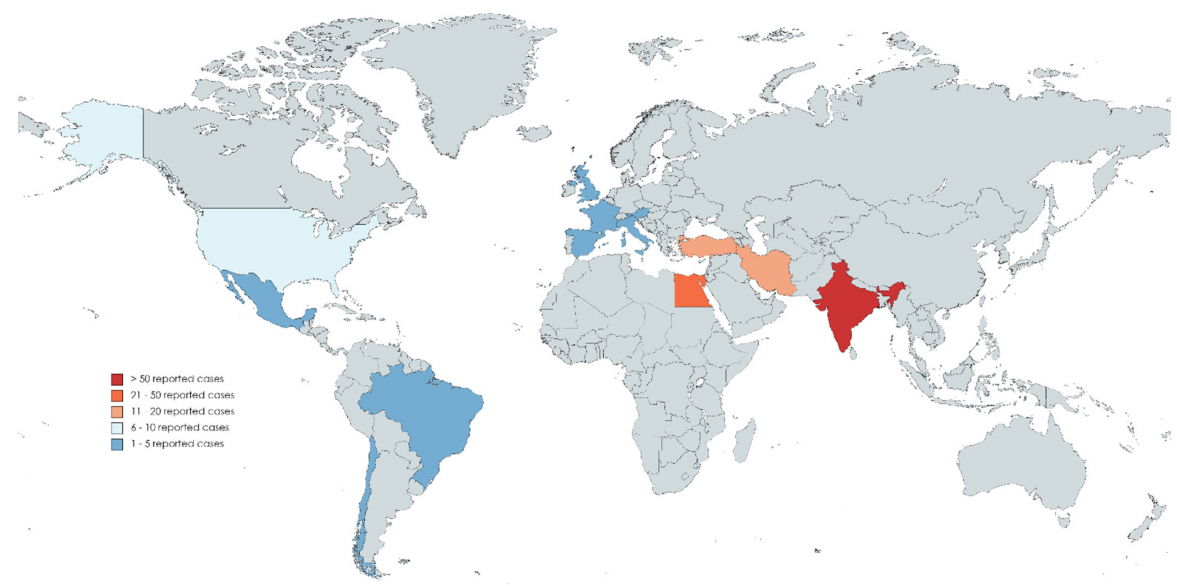
Figure 4. Global Distribution of COVID-19-associated Mucormycosis (CAM) Reported Cases, January 2020–May 2021.